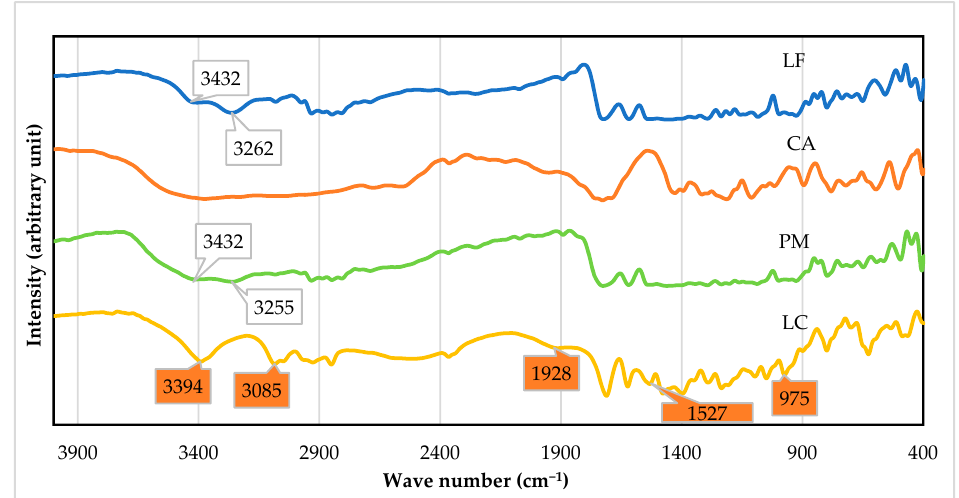
Figure 5. FTIR spectra of levofloxacin-citrate (LC) compared to levofloxacin (LF), citric acid (CA), and physical mixture (PM) of levofloxacin and citric acid. The new bands are depicted in the orange marks.